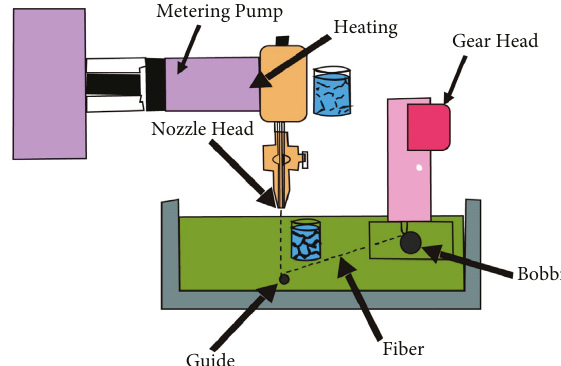
Figure 17: Schematic diagram for the laboratory spinning plant for the fiberization of silica wet